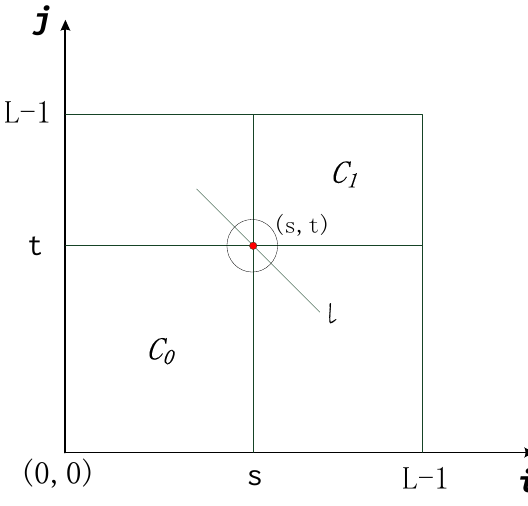
Fig. 3. Segmentation diagram based on two-dimensional histogram